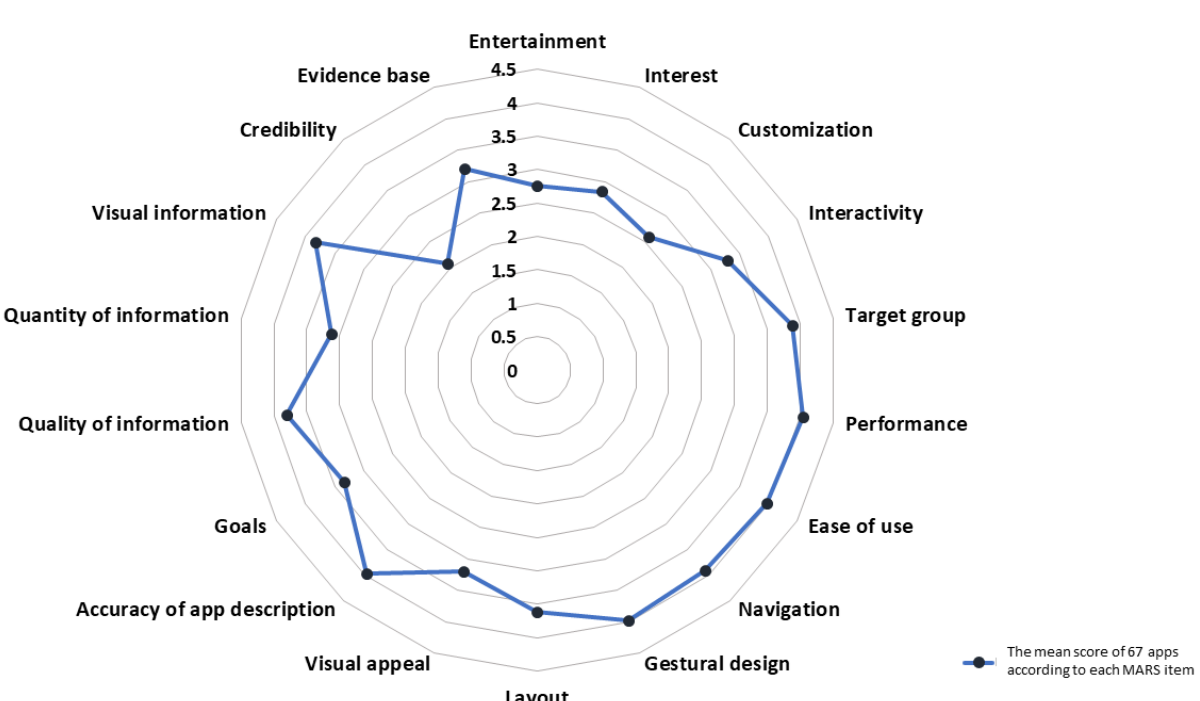
Figure 2. The average score of each Mobile App Rating Scale